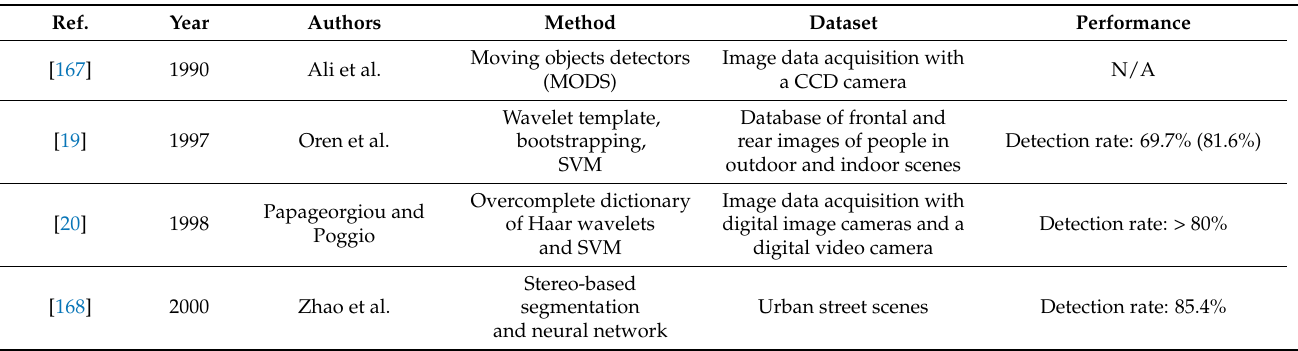
Table 6. Pedestrian Detection Studies with CV